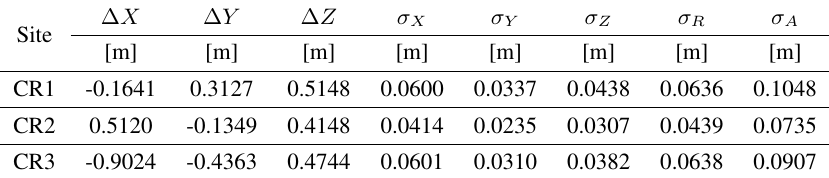
Table 4. Localization results of three CRs: difference between the estimated and the reference CR coordinates (∆ X, ∆ Y, ∆ Z ) , standard deviation of the estimated coordinates ( σ X , σ Y , σ Z ) , standard deviation of range and azimuth observations ( σ R , σ A ) . end of SAR image with 10 pixel margin, and calculate the cor- responding satellite position and velocity; (2) calculate the pro- jection of satellite velocity on the slant range direction accord- ing to the Doppler equation; (3) determine the CR’s imaging azimuth time using Newton iteration method.